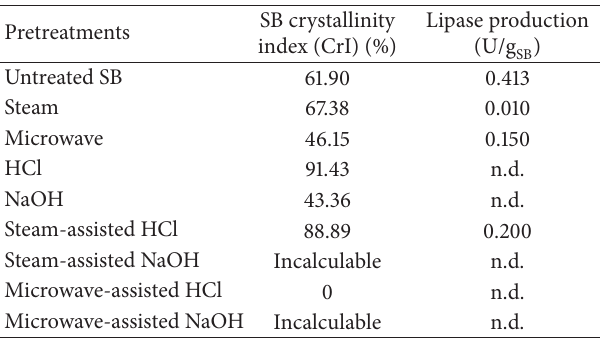
Table 1: Effects of various pretreatments on SB crystallinity index (CrI) and fungal lipase